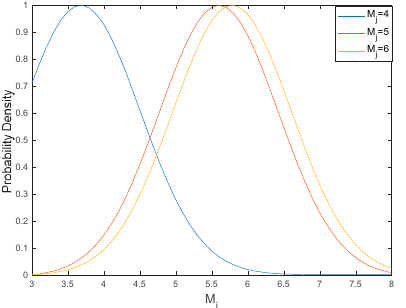
Figure 2. Probability density distribution of different M j earthquake early warning method based on Bayesian inference.